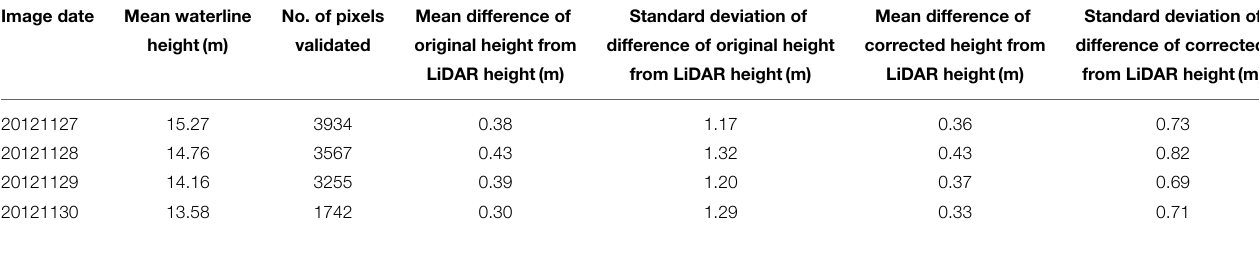
TABLE 1 | Comparison of original and corrected IDEM waterline heights to LiDAR heights.